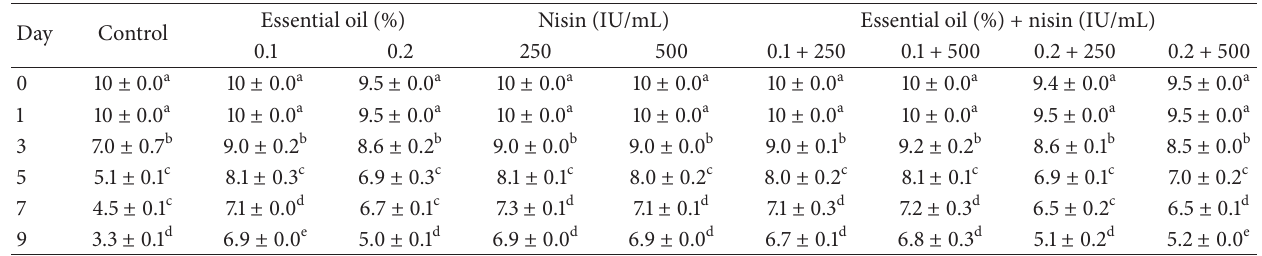
Means with different lowercase letters in the same column are significantly different ( 𝑝 < 0.05 ).